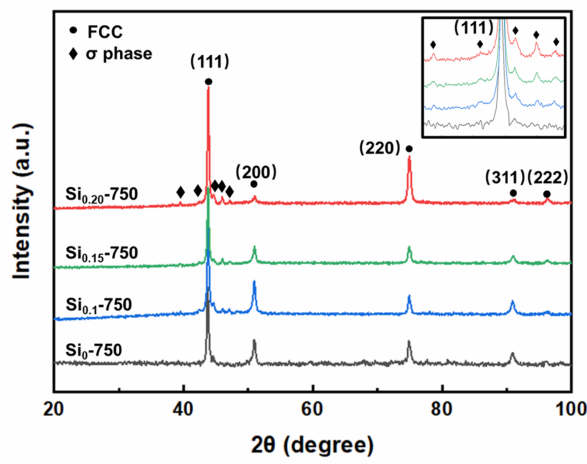
Figure 4. XRD patterns of the Si 0 -750, Si 0.1 -750, Si 0.15 -750, and Si 0.2 -750